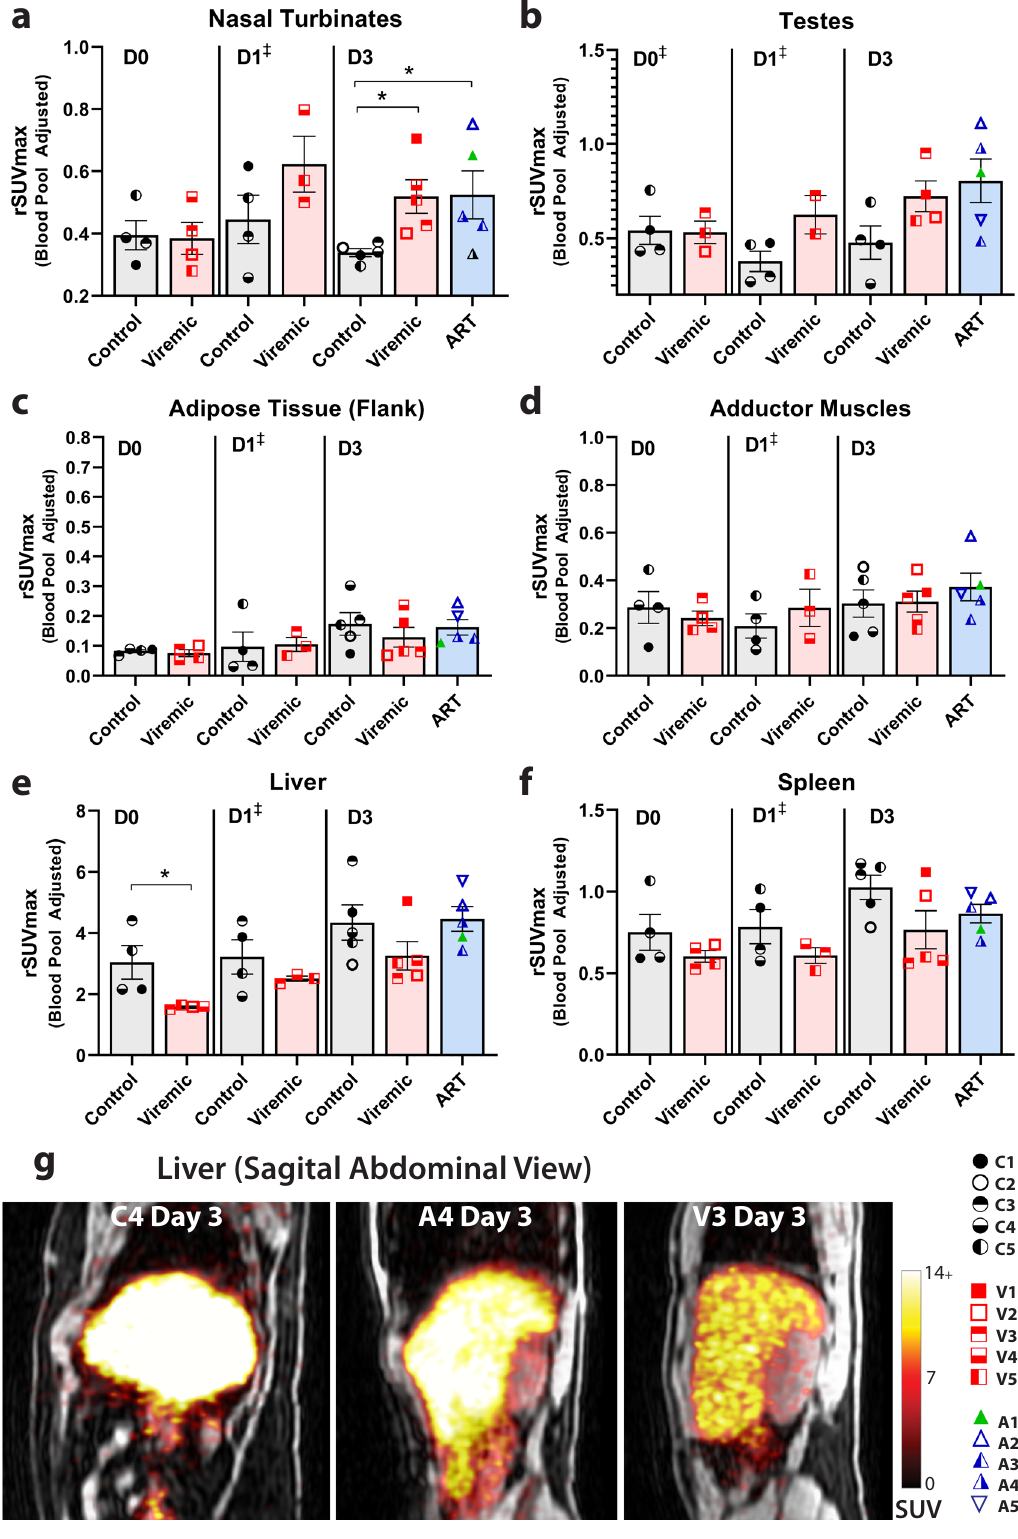
variants across the population. Whereas variations within avidity of VRC01 binding to participants ’ virus may bias correlations between HIV burden and tracer uptake, protein-tracer binding required for PET visualization may not require ef fi cient viral